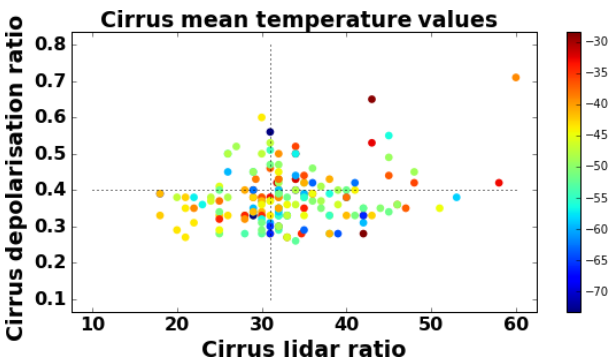
Figure 10. Dependencies of the mean temperature on the lidar ratio values at 355nm and the particle depolarisation